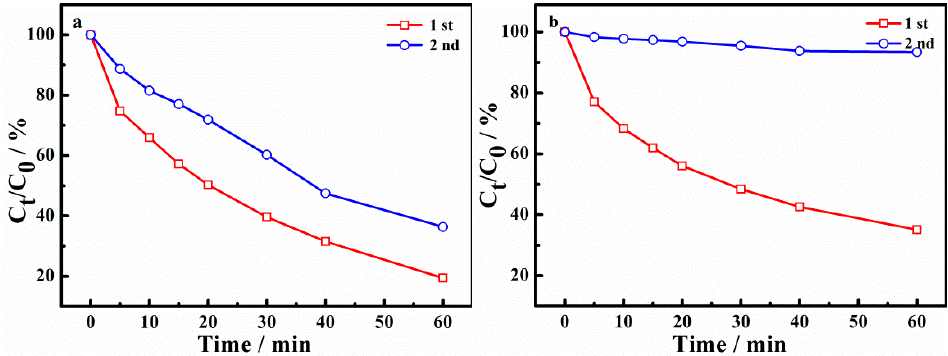
Figure 9. Reuse experiments. (The degradation of X-3B ( a ) and the absorption of X-3B ( b ).)